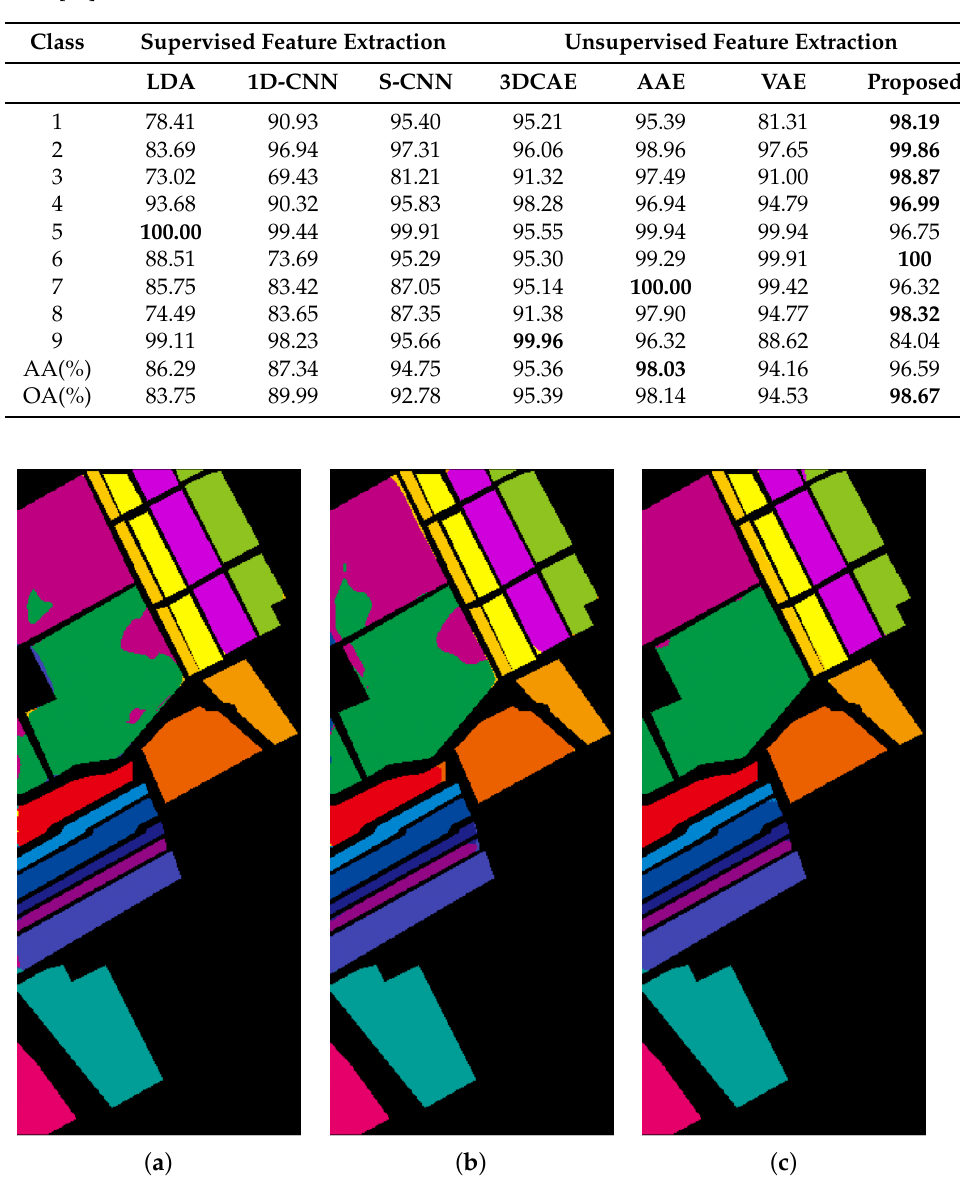
Figure 7. The classification maps of SV. ( a – c ) Classification results of AAE, VAE, and our proposed model,